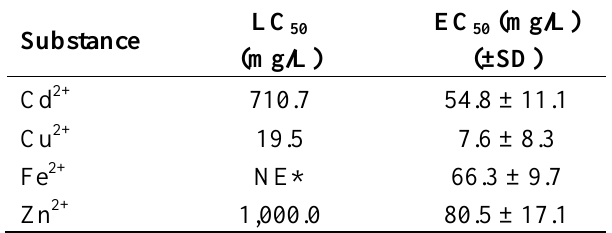
Table 4. The LC and EC values of the tested metals in mg/L as measured for the 50 50 mortality assay (probit analysis) and camera-based instrument (best fit